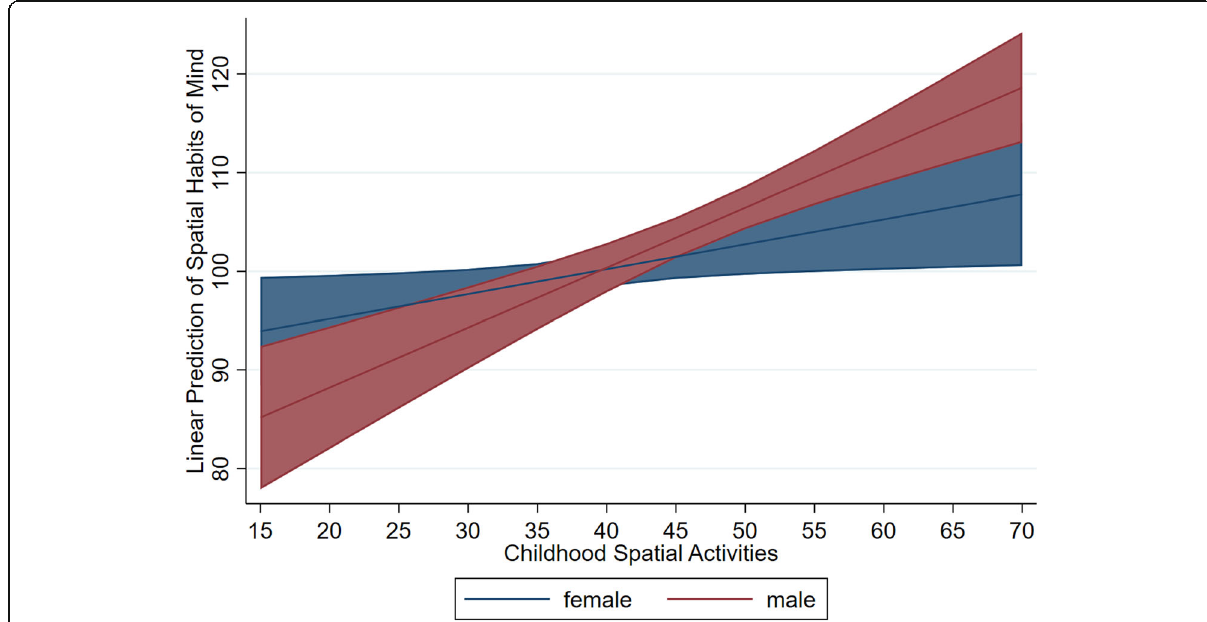
Fig. 3 Relation between Childhood Activities and Spatial Habits of Mind by Gender. Predictive margins of gender with 95%